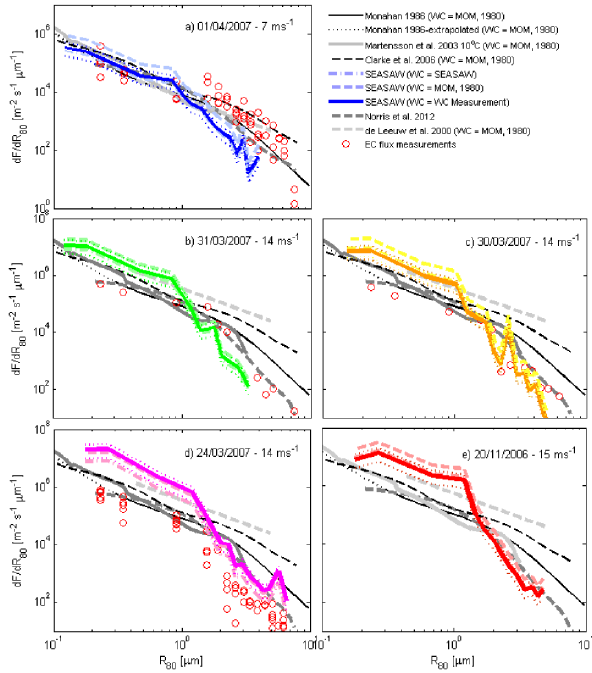
Fig. 9. Mean source fluxes using the production flux es- timates (coloured lines) and the measured whitecap fraction (solid lines), and whitecap parameterizations from Monahan and O’Muircheartaigh (1980) (dashed lines) and derived from SEASAW data (dot-dashed lines). The line colours correspond to those used in Figs. 4–7 to identify the deployment date. The dotted lines show the uncertainty around the source flux using the mea- sured whitecap coverage. All other source functions (black and grey lines) use the Monahan and O’Muircheartaigh (1980) (MOM, 1980) whitecap parameterisation. The individual 28-min average eddy co- variance aerosol flux measurements made during each of the five deployments are plotted as red circles. N.B. the y-axis scale on (a) is shifted relative to the other panels. N.B. the de Leeuw et al. (2000) production flux used is defined at 9ms − 1 , the maximum wind speed in their study (see Table 2) but is applied here up to 15ms − 1